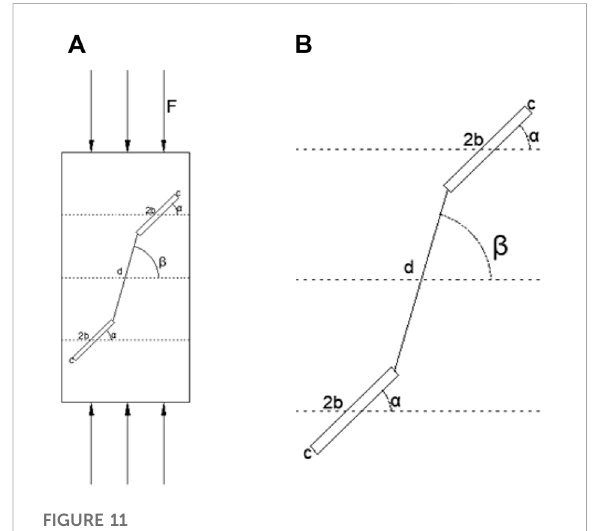
FIGURE 11 Numerical calculation model: (A) double-crack axial force diagram; (B) partial enlarged view of the rock bridge.